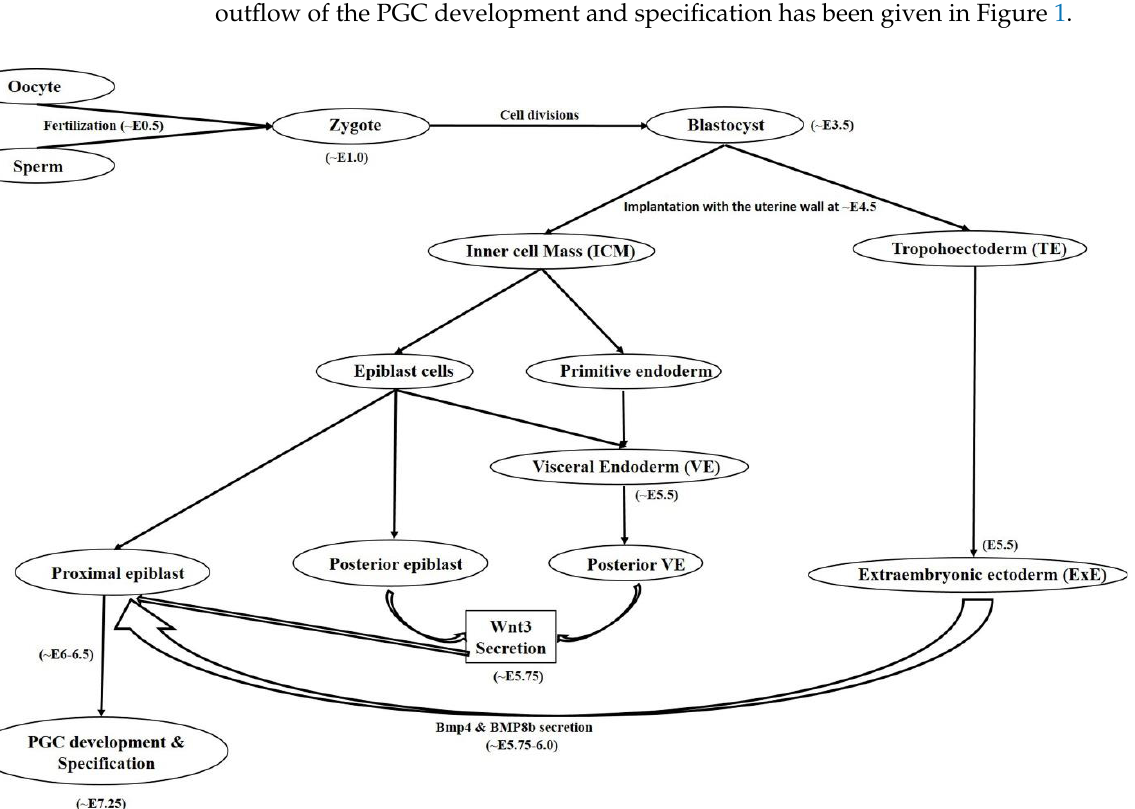
Figure 1. Diagrammatical outflow of the PGC development and specification in mice. Oocyte and sperm after getting fertilized produces zygote. While undergoing further cell divisions, zygote attain blastocyst stage at around embryonic development day 3.5 (~E3.5) having an outer trophoblast cell monolayer and pluripotent inner cell mass (ICM) which is further separated into epiblast and primitive endoderm. Implantation of the blastocyst with the uterine wall takes place at ~E4.5. Further developmental stages are comprised of extraembryonic ectoderm (ExE) development from trophoectoderm and visceral endoderm (VE) from primitive endoderm. Furthermore, Wnt3 is secreted by both of the posterior epiblast and VE and BMP4 & BMP8b secreted by ExE. Wnt3 and BMPs secretions finally assists in production of a few primordial germ cells (PGCs) from proximal epiblast and finally PGC specification takes place.